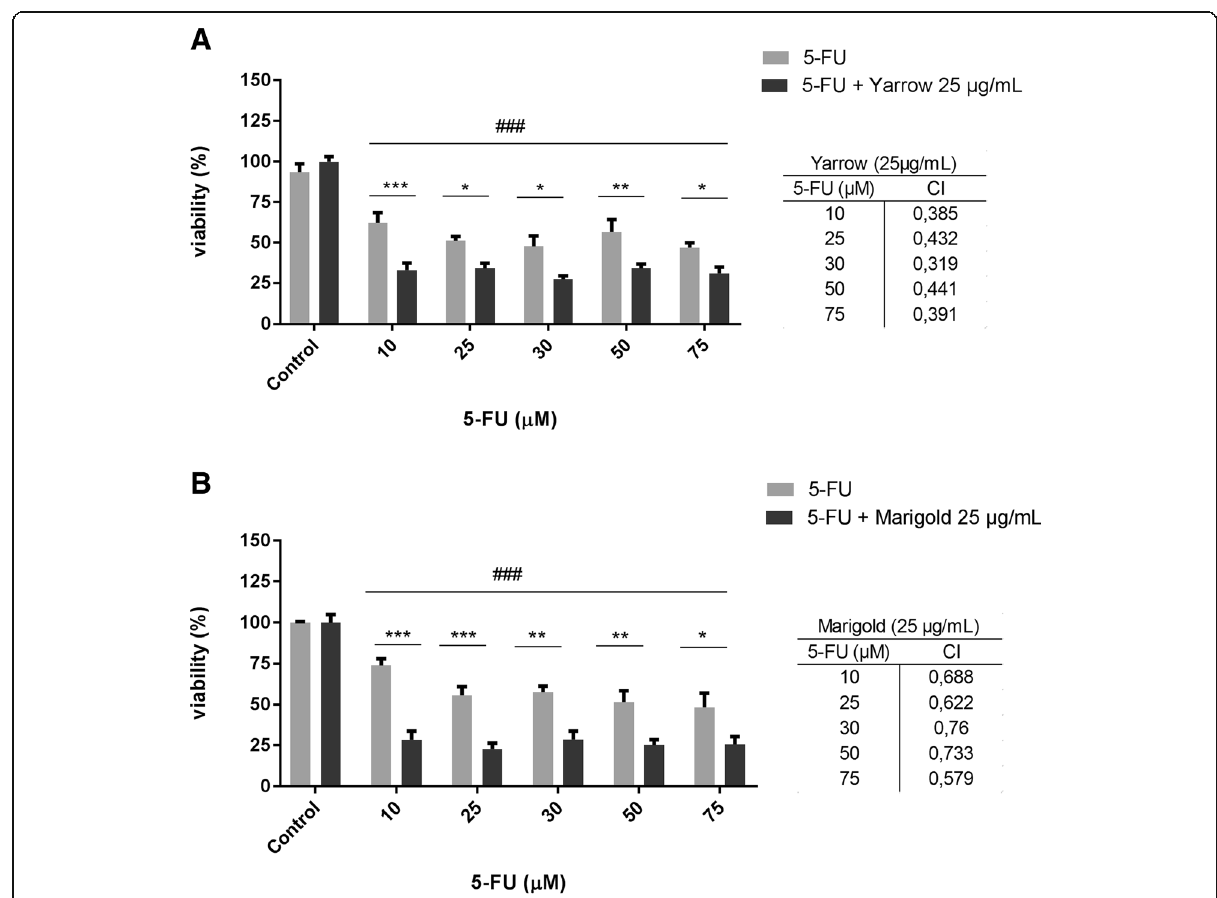
Fig. 6 MIA PaCa-2 response and Combination Index (CI) when cells were pre-treated 8 h with A) Yarrow or B) Marigold, followed by an exposure of increased doses of 5-FU for 72 h. Data represent means ± S.E.M of at three independent experiments each performed in quadruplicate. Asterisks (*) indicate statistical differences between 5-FU and Yarrow/Marigold+ 5-FU treatments * p < 0.05; ** p < 0.01 *** p < 0.001. # indicates statistical differences in treated cells with respect to the control (DMSO 0.1%). ### p <